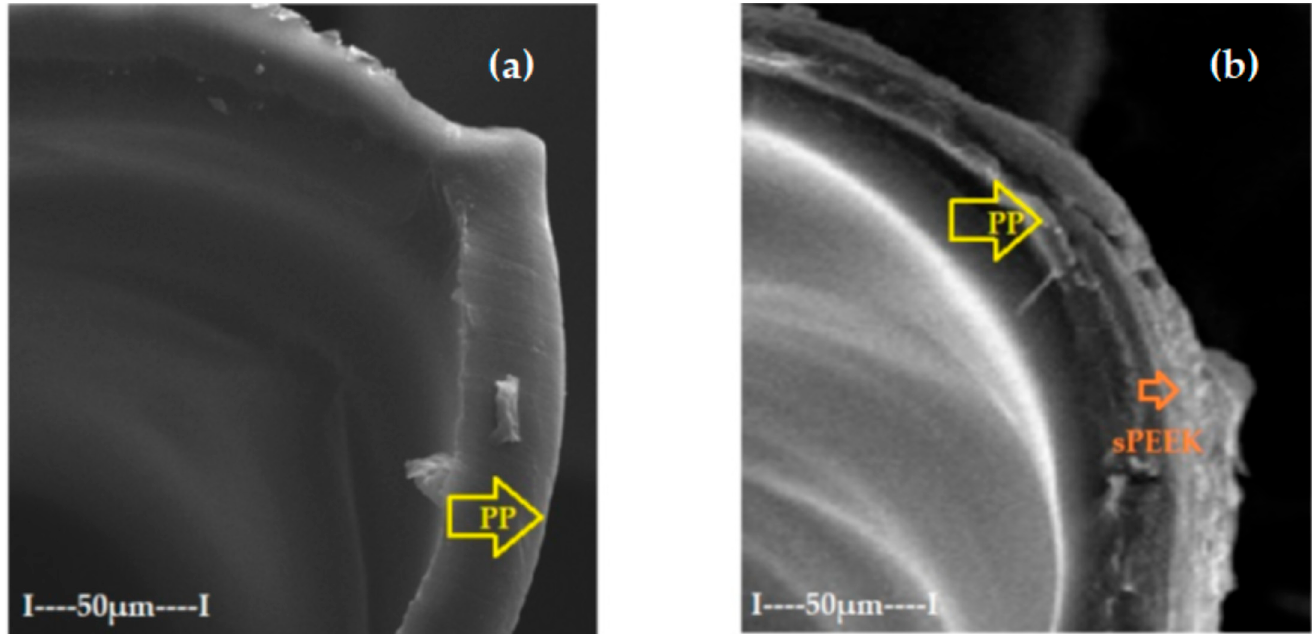
Figure 5. Scanning Electron Microscopy (SEM) details on polypropylene hollow-fiber membranes (PPHF) ( a ); and composite membranes ( b ).